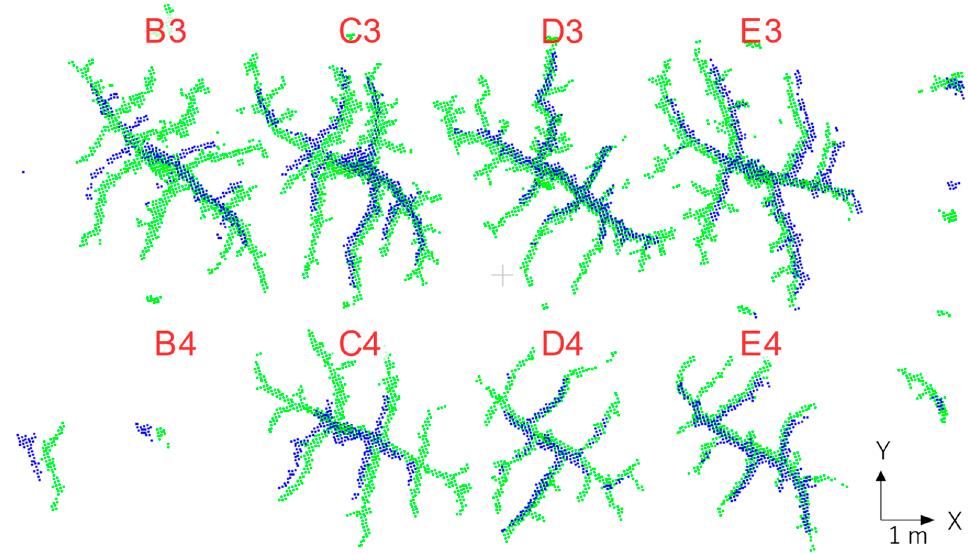
Figure 10. The voxel point clouds for the data before and after pruning; blue points indicate before pruning, and green points indicate after pruning. B3–E4 represent the ID of tree; ( top ): 3D lidar SLAM; ( middle ): UAV-SfM point cloud; ( bottom ): UAV-SfM dense point cloud. Table 4. Relationship between fresh weight and estimated volume value in different blocks at the experimental